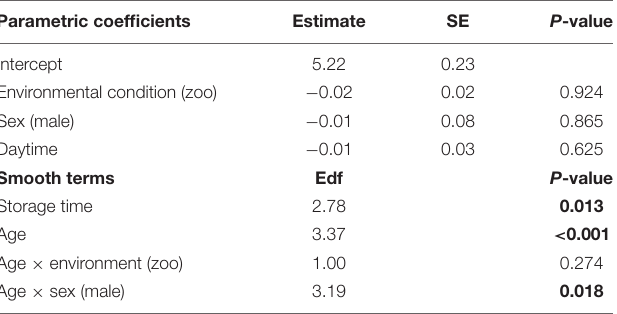
TABLE 1 | Estimates of parametric coefficients and effective degrees of freedom of smooth terms for urinary neopterin levels in bonobos between birth and 18